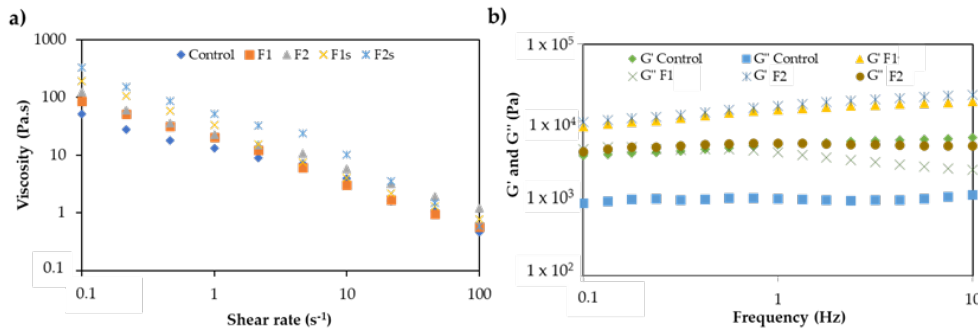
Figure 2. ( a ) Viscosity flow behavior of lab scale (F1 and F2) and pilot lab scale (F1s and F2s) formulations after manufacturing, and ( b ) viscoelastic behavior of lab-scale emulsions (F1 and F2).